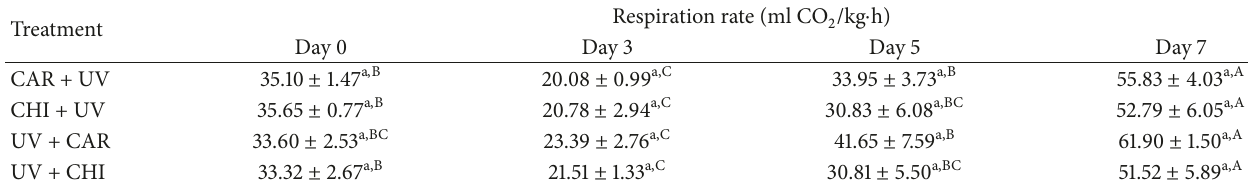
Table 2: The effect of different UV-C and edible coating combinations on respiration rate of longan fruits. Treatment